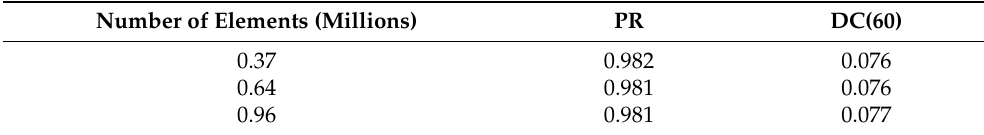
Figure 10. Hexahedral computational mesh generated using ICEM CFD. Table 2. Mesh sensitivity